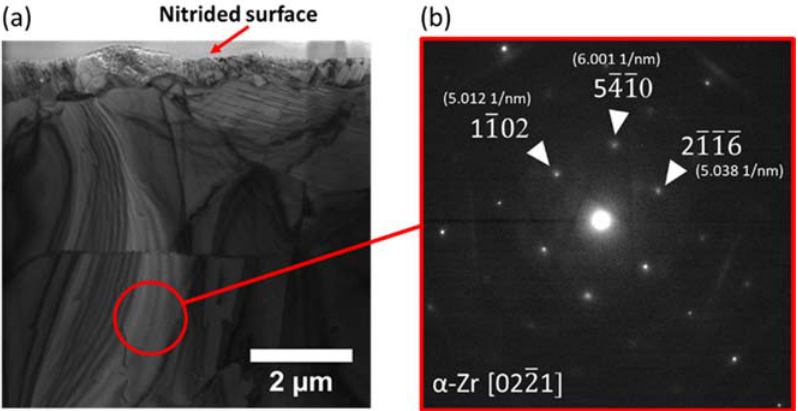
Figure 4. ( a ) Cross-sectional TEM micrograph of nitrided Zr, ( b ) the micrograph of the near surface region marked with a red square in ( a ), and ( c ) localized diffraction pattern obtained from the near surface region marked with a blue circle in ( b ).